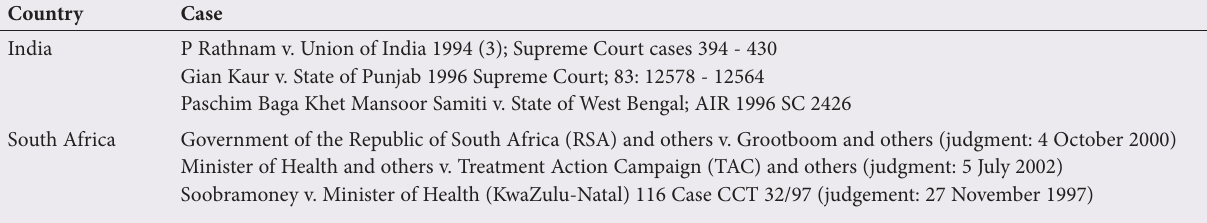
Table 2. The right to healthcare and access to emergency care: Case precedents Country Case